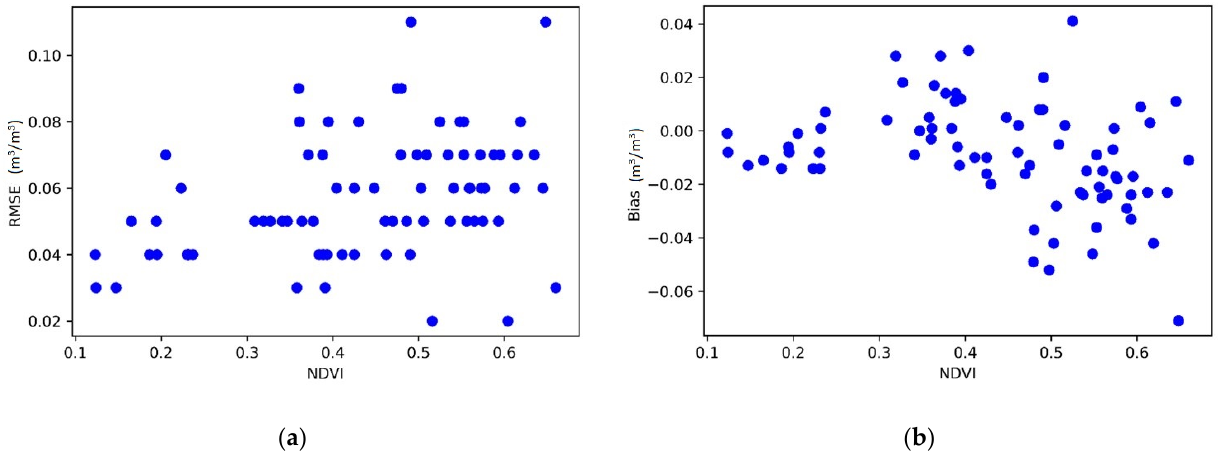
Figure 7. Scatterplots of statistical parameters of the hybrid approach performance to retrieve SSM as a function of NDVI values stations: ( a ) RMSE , ( b ) Bias .